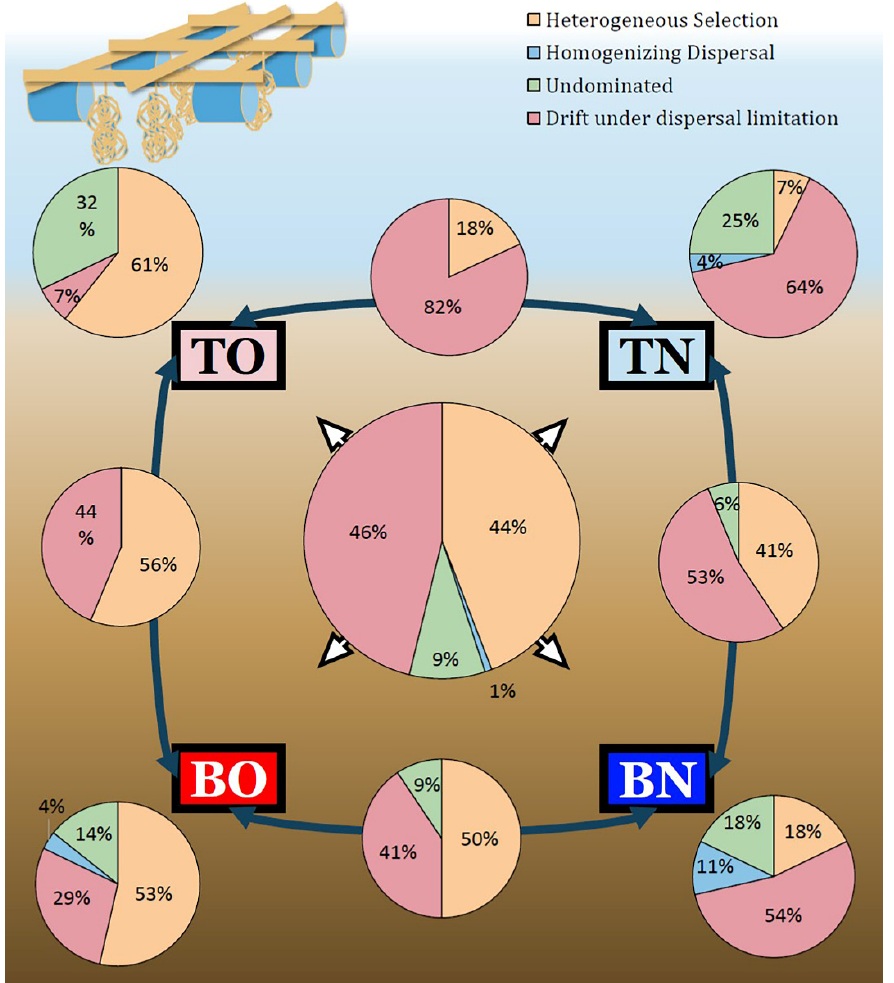
Figure 4. Contributions of different processes to community assembly. Sample groups are indicated by squares. Pie charts located at the four corners of the figure depict the relative contribution of processes in community turnover within groups. The pie charts on dark-blue double-headed arrows show the contribution proportions of various processes to the difference between the two groups connected by the arrow. The pie chart in the center indicates the contribution of processes in overall community assembly. (TO: the top layer of the oyster-culturing area; BO: the bottom layer of the oyster-culturing area; TN: the top layer of the non-culture area; BN: the bottom layer of the non-culture area).